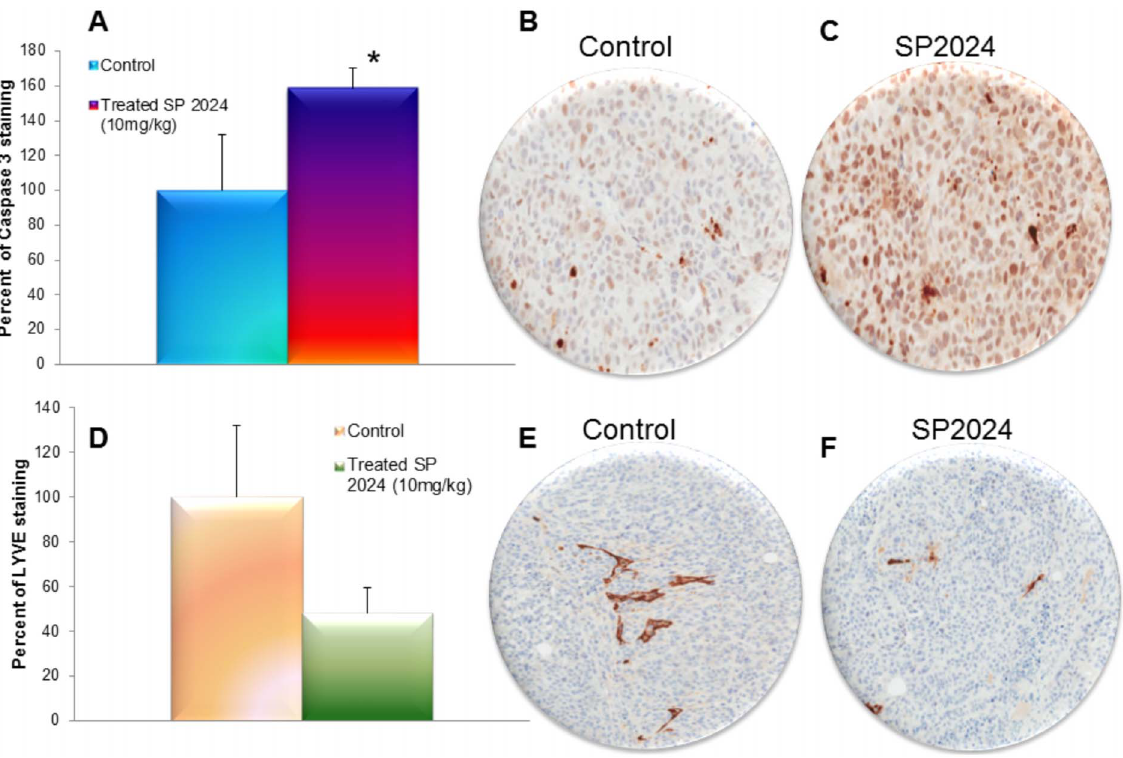
Figure 7. Caspase-3 and lymphatic vessels quantification. Assessment of the levels of caspase-3 in control and SP2024-treated tumor sections. (A) Significant increase (p , 0.05) of caspase-3 in the treated tumors in comparison to the untreated tumors (B and C). Representative images of untreated tumor section (B) and treated tumor section (C). (D) Quantification of the lymphatic vasculature in the control group in comparison to the treated group. There was no statistical significance due to the scarcity of lymphatic vasculature but the difference between the two groups was visible on tumor sections. (E and F) Representative images of the control and the treated group respectively.